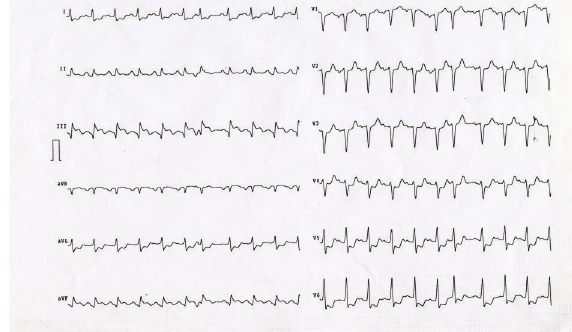
Figure 1: ECG recorded after some hours the onset of the sintomatology, it presents di ff use ST-segment depression to D1 and a VL leads and from V4 to V6 precordial leads with supraventricular ectopic beats.